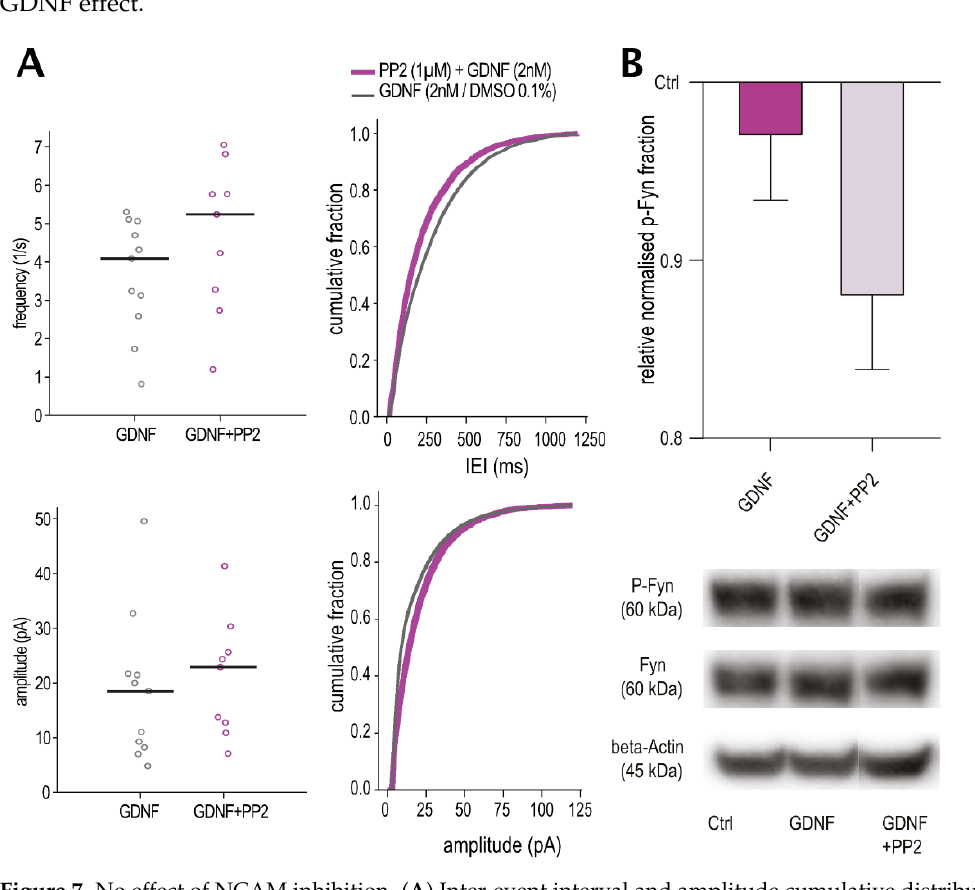
Figure 7. No effect of NCAM inhibition. ( A ) Inter-event interval and amplitude cumulative distribution plots of spontaneous IPSCs from GDNF and GDNF + PP2-incubated slices (n = 511 events per cell). The line markers in the scatter plots depict the median of averages per cell. Mann–Whitney test for the averages–not significant, Kolmogorov–Smirnov test for distribution comparisons (IEI: D = 0.126, amplitude: D = 0.155). ( B ) Relative change in phosphorylation ratio of Fyn after treatment with GDNF and GDNF + PP2 compared to control (n = 4). Example images of Western blot membrane staining depicted below. Data represented as mean and SEM. Friedman test—not significant.